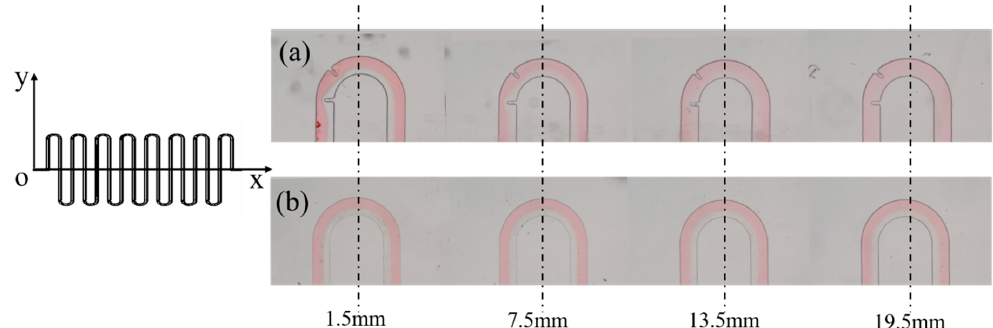
Figure 8. Experimental results of mixing performance of ( a ) S-shaped micromixer with embedded baffle and ( b ) S-shaped micromixer. The evenness of the red colored distribution indicates the mixing efficiency.